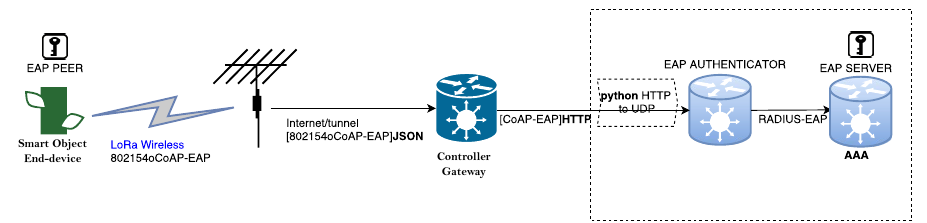
Figure 10. Architecture of the LoRaFabian network.